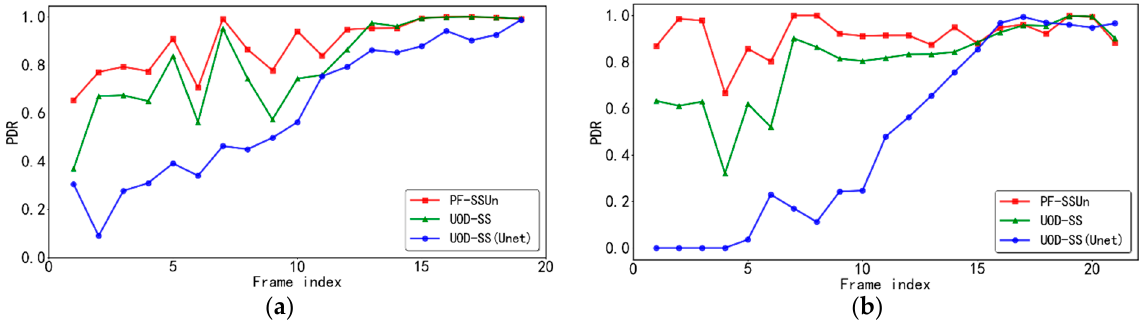
Figure 8. Comparison of frame-by-frame detection rate of the three semantically relevant methods: ( a ) Scene 1; ( b ) Scene 2.